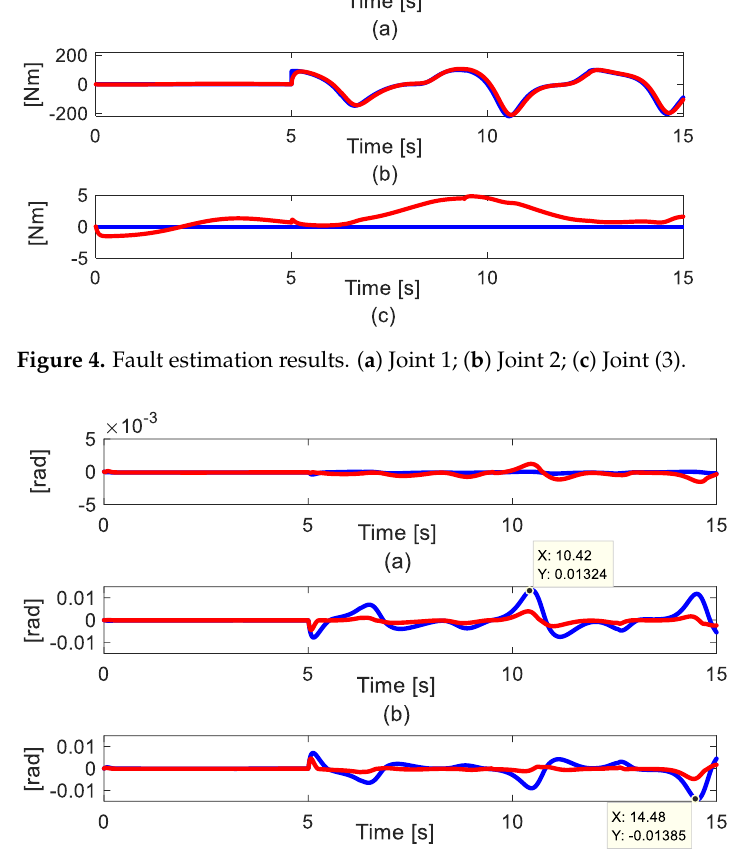
Figure 5. Tracking error results. Blue line is [30]+ESO controller. Red line is the proposed controller. ( a ) Joint 1; ( b ) Joint 2; ( c ) Joint (3).